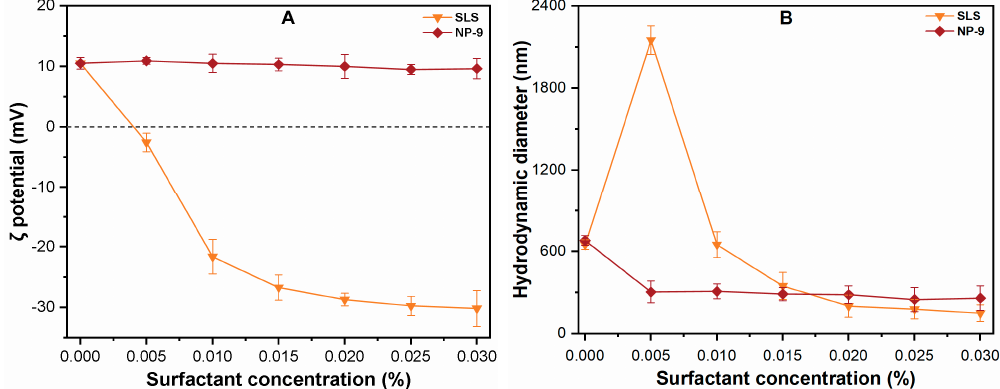
Figure 3. Effects of surfactants concentration (0–0.030%) on the ( A ) ζ potential; ( B ) hydrodynamic diameter of CuO NPs suspension at pH (7.0 ± 0.1).